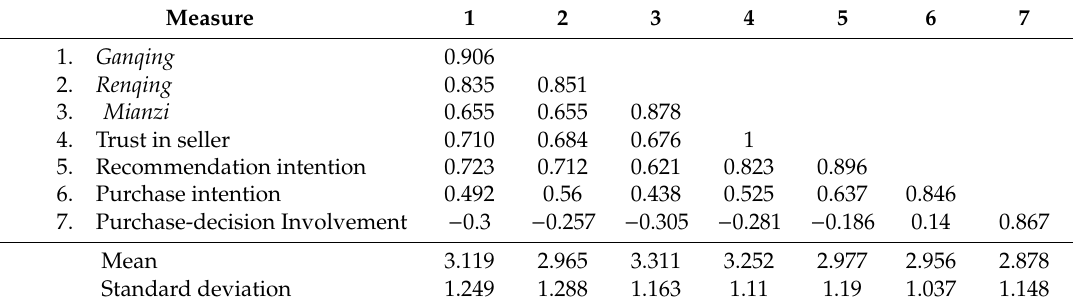
Table 2. Descriptive statistics and discriminant validity assessment of the measurement